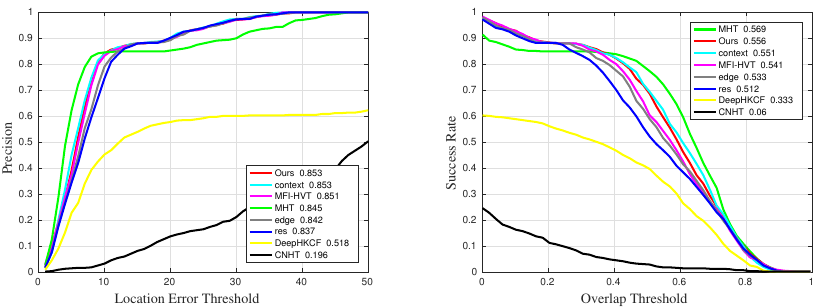
Figure 19. Precision and success rate under OCC challenge.